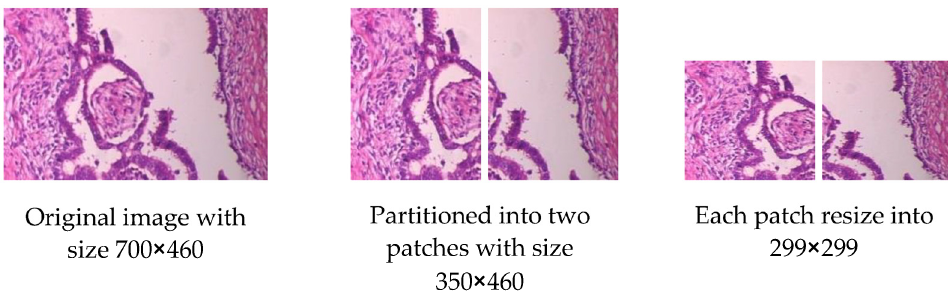
Figure 7. Example for Partitioning and resizing a BreakHis dataset.